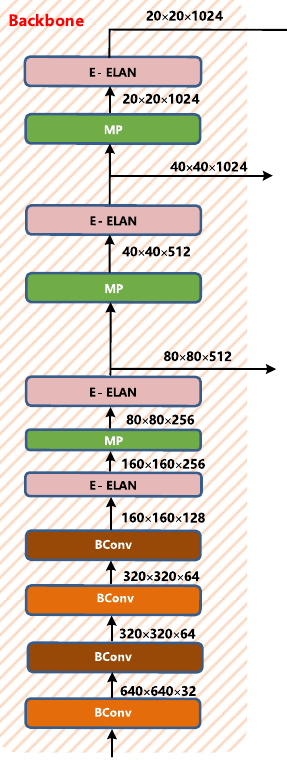
Figure 6. Backbone structure of YOLOv7.